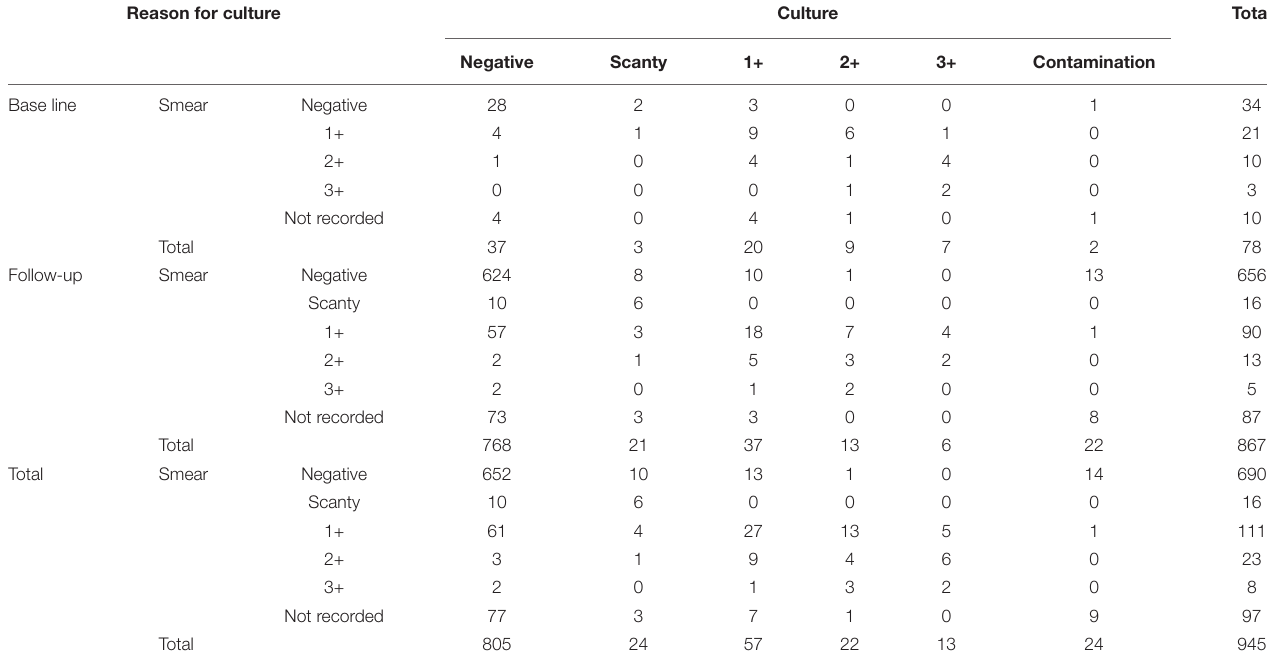
TABLE 1 | Frequency of smear microscopy result, reason of specimen cultivation, and culture result. Reason for culture